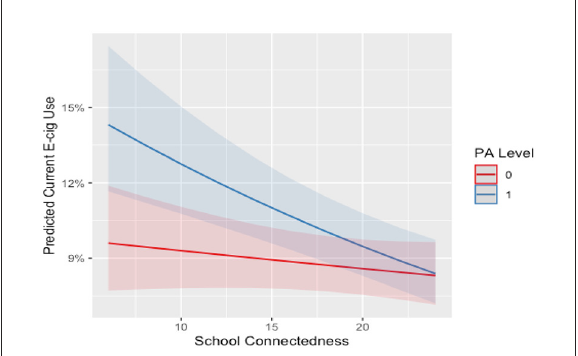
FIGURE2 Interaction between school connectedness and outside of school sport on current E-cigarette use for males. E-cig, E-cigarette; 0, not participating; 1, participating. Line and shade, mean and